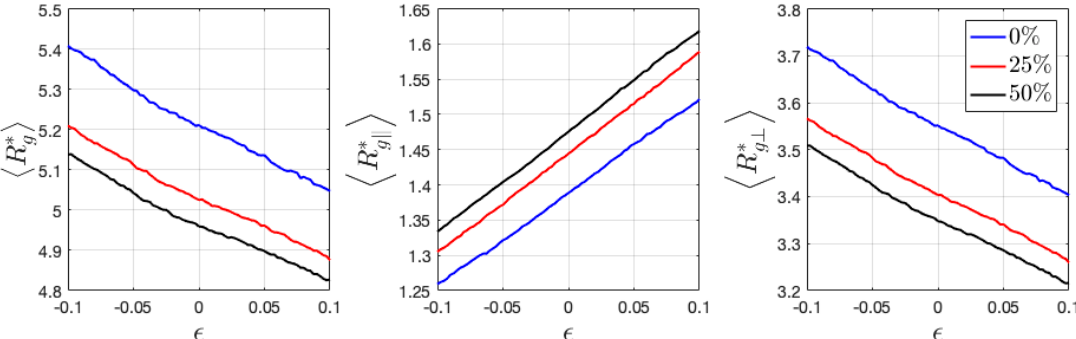
(cid:105) g (cid:107)